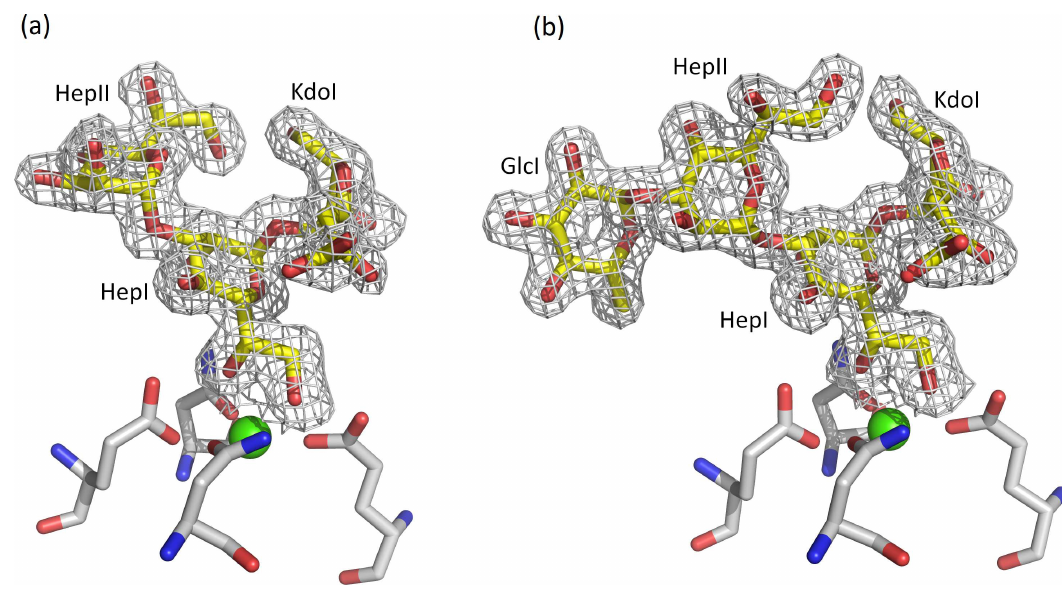
Fig 4. Electron density for the Salmonellaenterica oligosaccharides bound to rfhSP-D (subunit B) with HepI in the Ca1 binding site. The calcium ion is in green and the four calcium and ligand coordinating residues Glu321, Asn323, Glu329 and Asn341 are shown in cpk. (a) R7 oligosaccharide KdoI (anhydro)-HepI-HepII (b) R5 oligosaccharide KdoI (anhydro)-HepI-HepII-Glc1. Maps are 2mFo-DFc contoured at 1 σ .